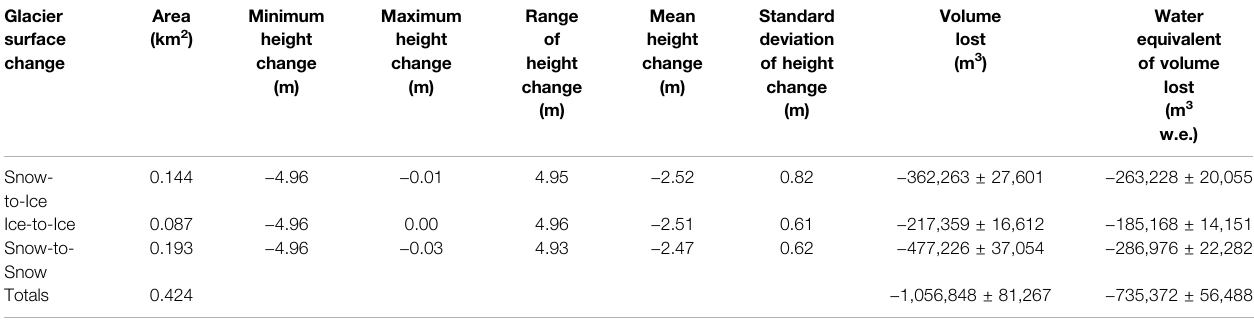
TABLE 2 | Surface height differences between the DEMs of the Sholes Glacier on August 17, 2020 and September 5, 2020. The surface height changes are separated into three surface type classes based on the IsoData unsupervised classi fi cation. Statistics were calculated based on each surface type class. Glacier